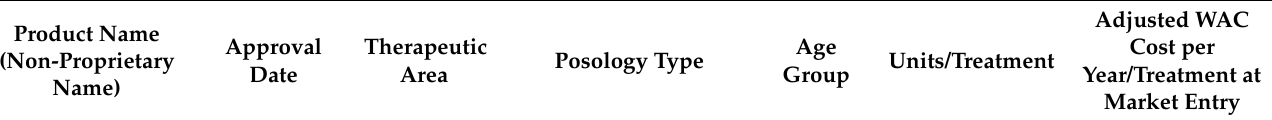
Table A1. The treatment costs of new molecular entities and new biologics at market entry,